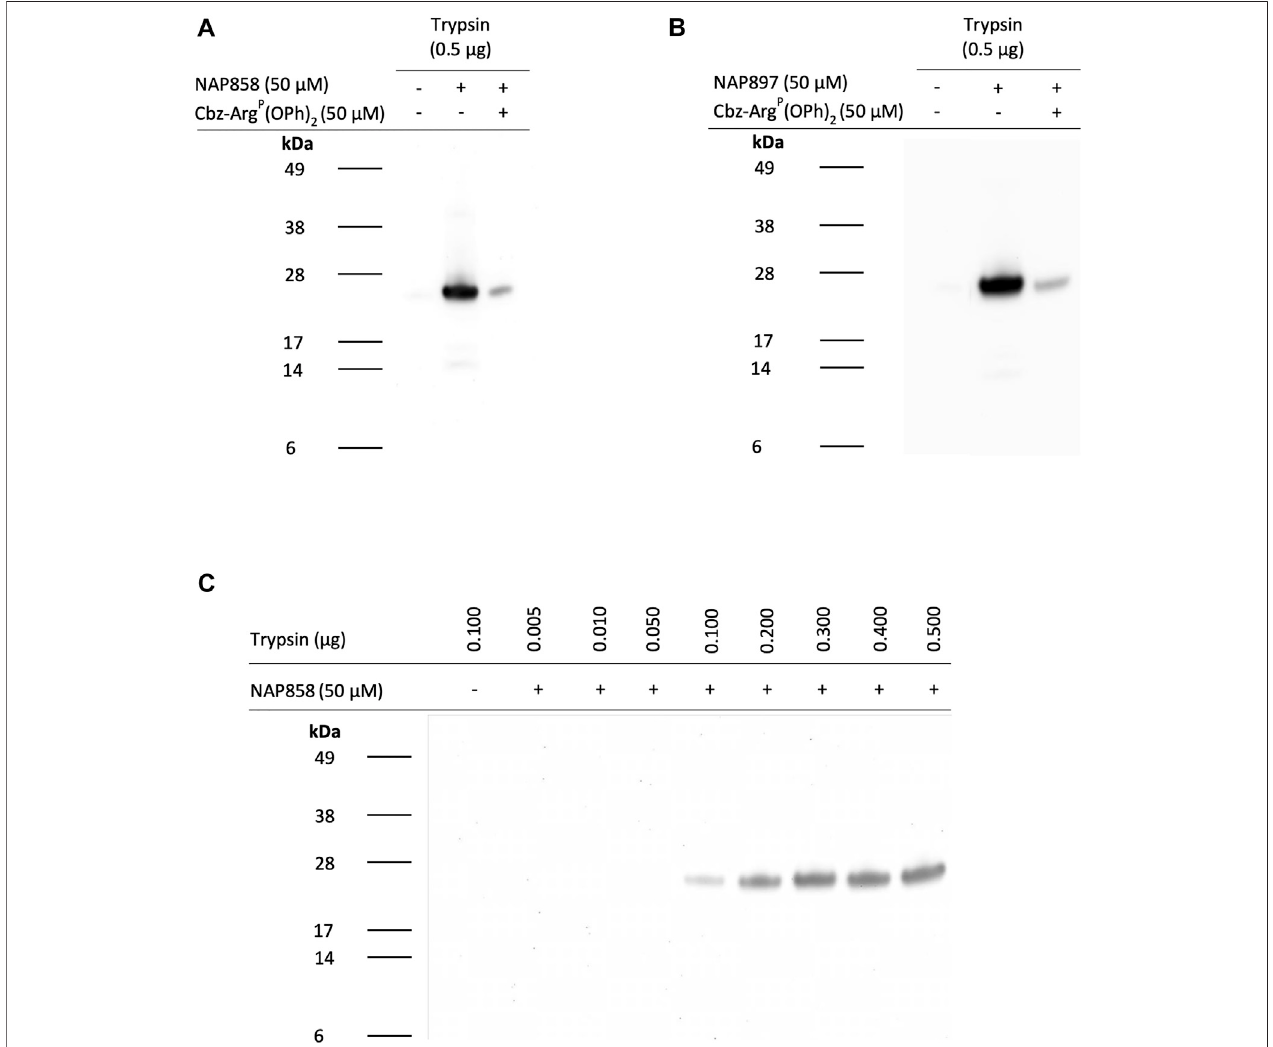
FIGURE 9 | NAP858 and NAP897 function as activity-based probes (ABPs) for trypsin. Samples of trypsin were treated with either (A) NAP858 (+) or (B) NAP897 (+),usedataconcentrationof50 μ M,for30min,at37 ° C.Foreach blotavehiclecontrolsamplewasincluded( − / − )aswellasafurthersampleoftrypsinpre-treatedwith Cbz-Arg P (OPh) 2 (+)priortoincubationwiththeAPs. (C) Solutionscontainingascendingamountsoftrypsin(0.01 – 0.5 μ g/ml)werealsoincubatedwithNAP858(+),under exactly the same conditions as indicated for panels (A) and (B) , above. All treated samples were reduced prior to SDS-PAGE. Western blotting analysis was then performed which allowed visualisation of the biotinylated inhibitor-protease complex using streptavidin-HRP.